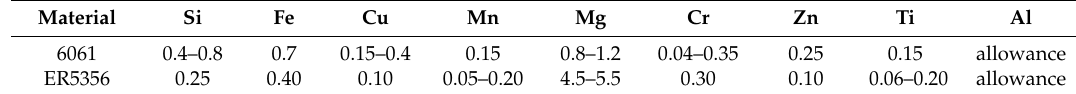
Table 1. Composition of welding materials.